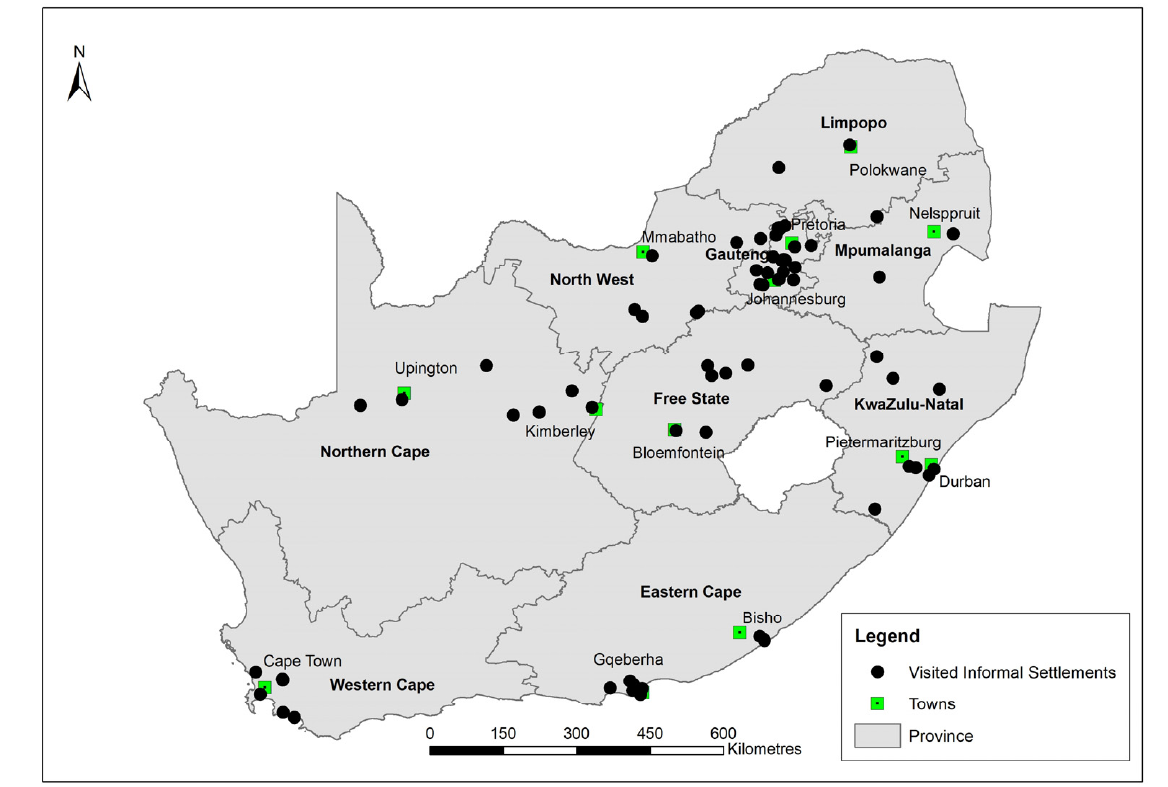
Figure 1. Visited informal settlements across the country.